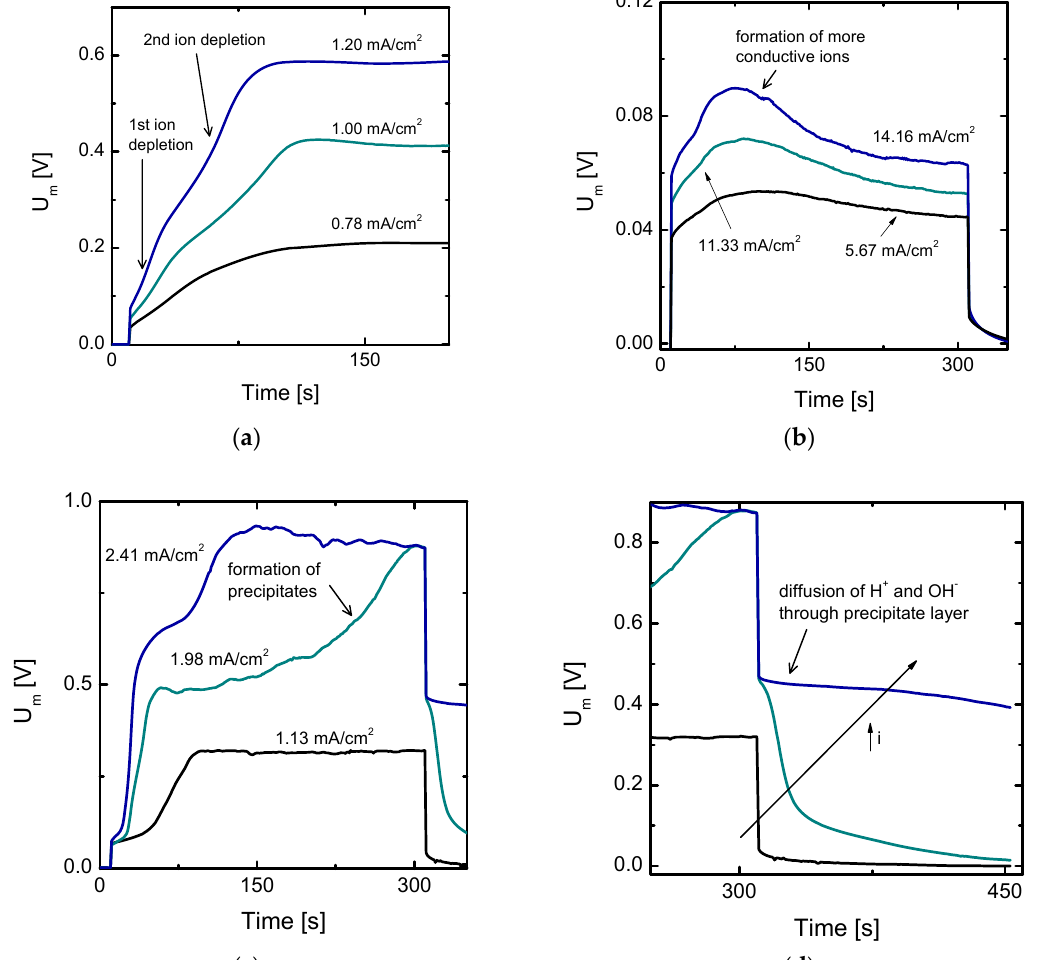
Figure 2. Examples of chronopotentiograms characteristic of phenomena related to shifts in the equilibrium at the depleting diffusion boundary layer of cation-exchange membranes. ( a ) Curves obtained when different species become depleted at the membrane surface, experiments conducted with 2.5 × 10 − 3 M Cr 2 (SO 4 ) 3 ; ( b ) Curves obtained when equilibrium is shifted towards formation of more mobile ions using 2 × 10 − 2 M Fe 2 (SO 4 ) 3 solutions; ( c ) Curves obtained during formation of precipitates at the membrane surface using 10 − 2 M NiSO 4 solutions; ( d ) Membrane potential relaxation profile after formation of precipitates at the membrane surface.